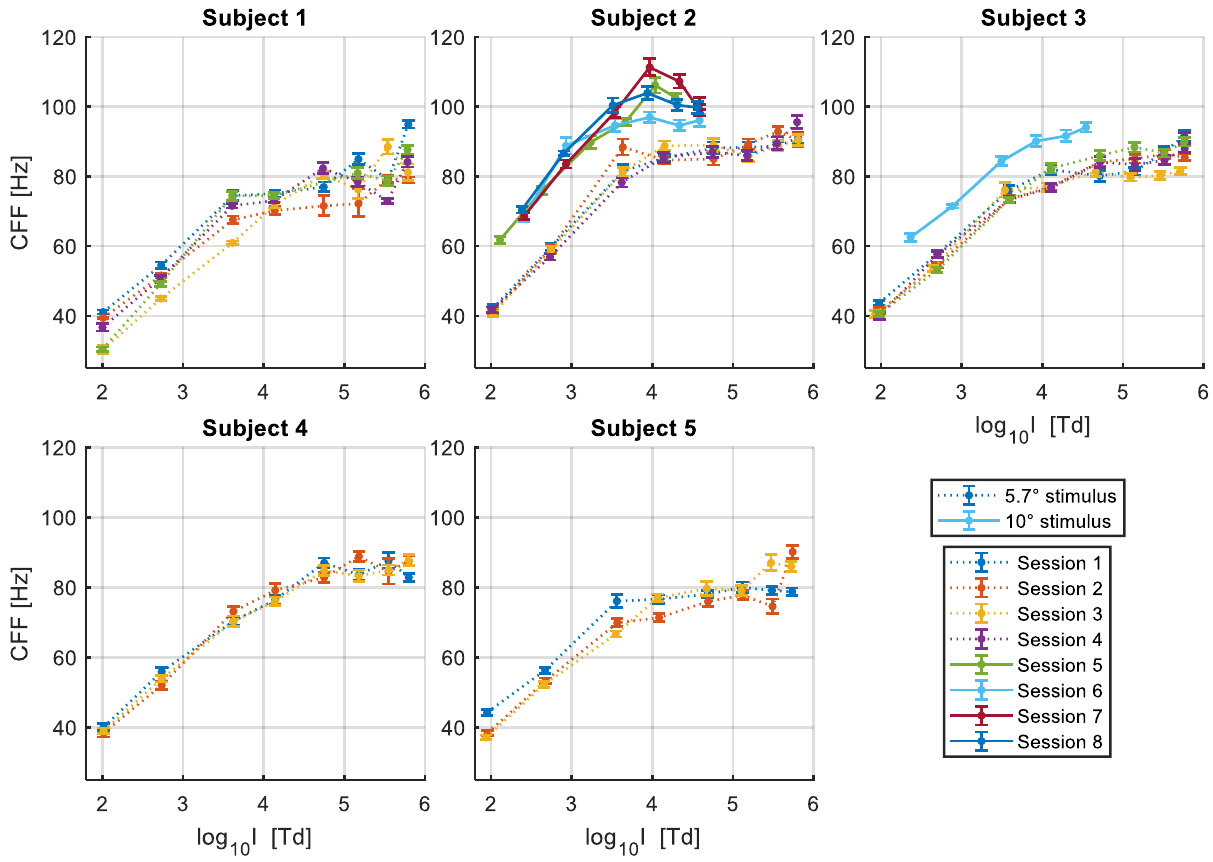
Figure 4. Estimated CFFs as a function of log 10 retinal illuminance. Error bars represent the standard error of the CFFs obtained through parametric bootstrap analysis. Different sessions are represented with different colors. The dotted lines represent CFFs obtained for a stimulus of 5.7 degrees of visual angle, and the continuous lines for a stimulus of 10 degrees of visual angle.